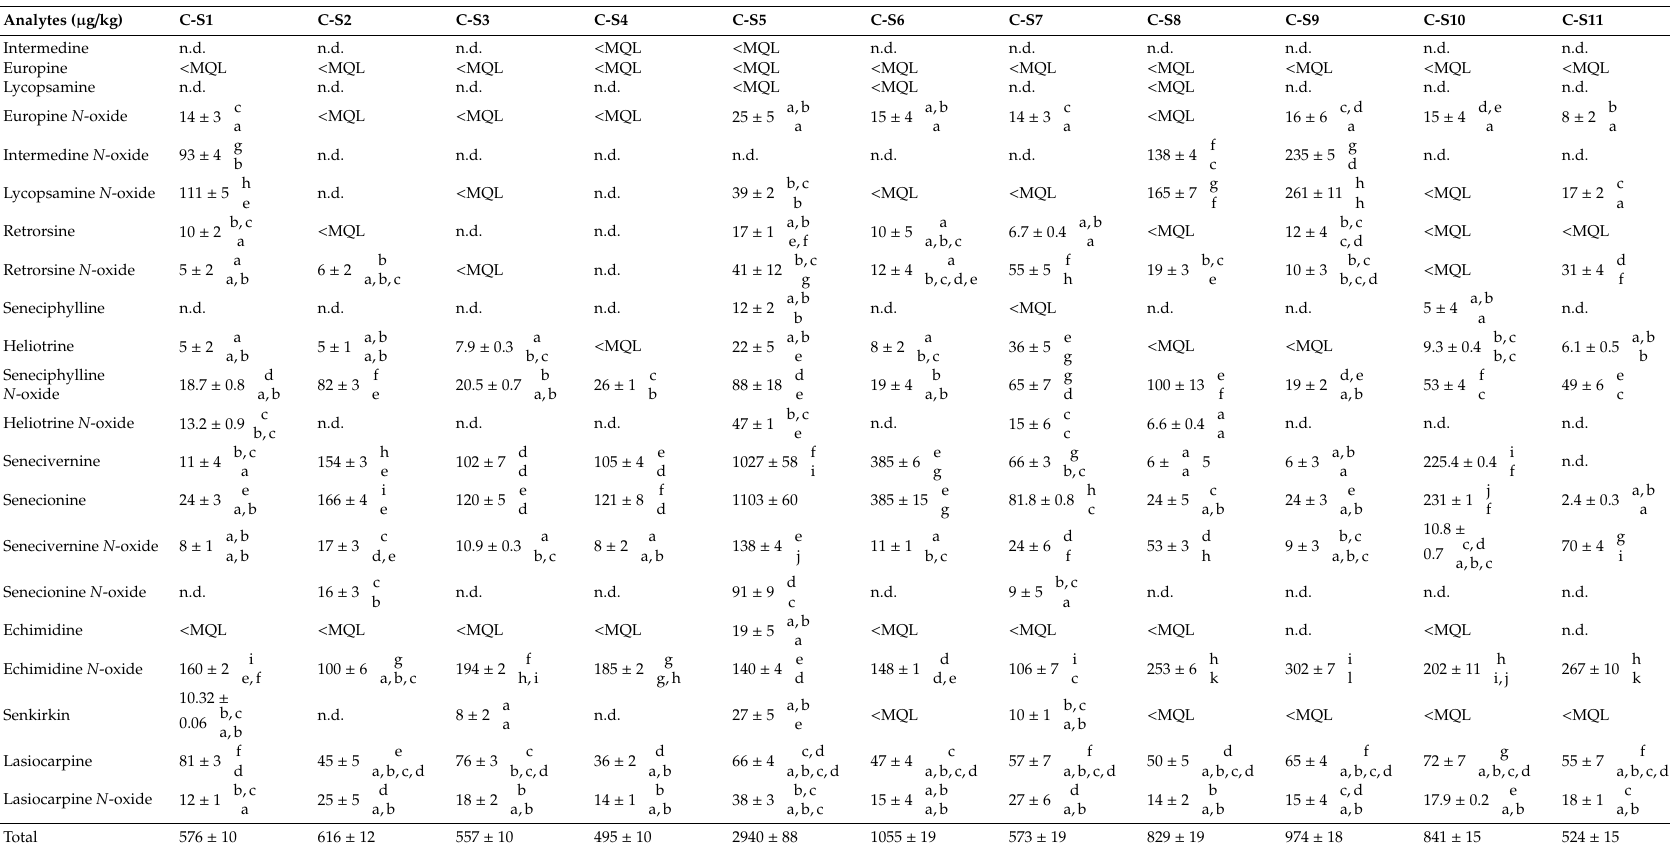
Table 3. Content of the target PAs / PANOs ( µ g / kg) quantified in the di ff erent oregano samples analyzed by the µ -QuEChERS method